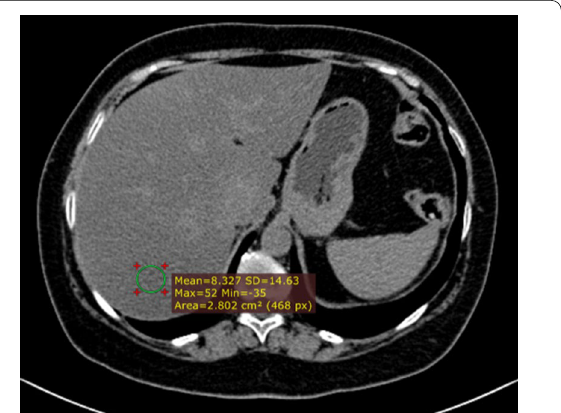
Fig. 14 59-year-old woman with history of hysterectomy, bilateral salpingo-oophorectomy and segmental resection of distal left ureter for uterine leiomyosarcoma, and tumor relapse at first CT follow-up after 3 months from surgery and then treated with chemotherapy (doxurubicine-dacarbazine). Precontrast CT at 3 months after chemotherapy shows low attenuation of the liver parenchyma with an absolute value of 8 HU, consistent with post-ChT